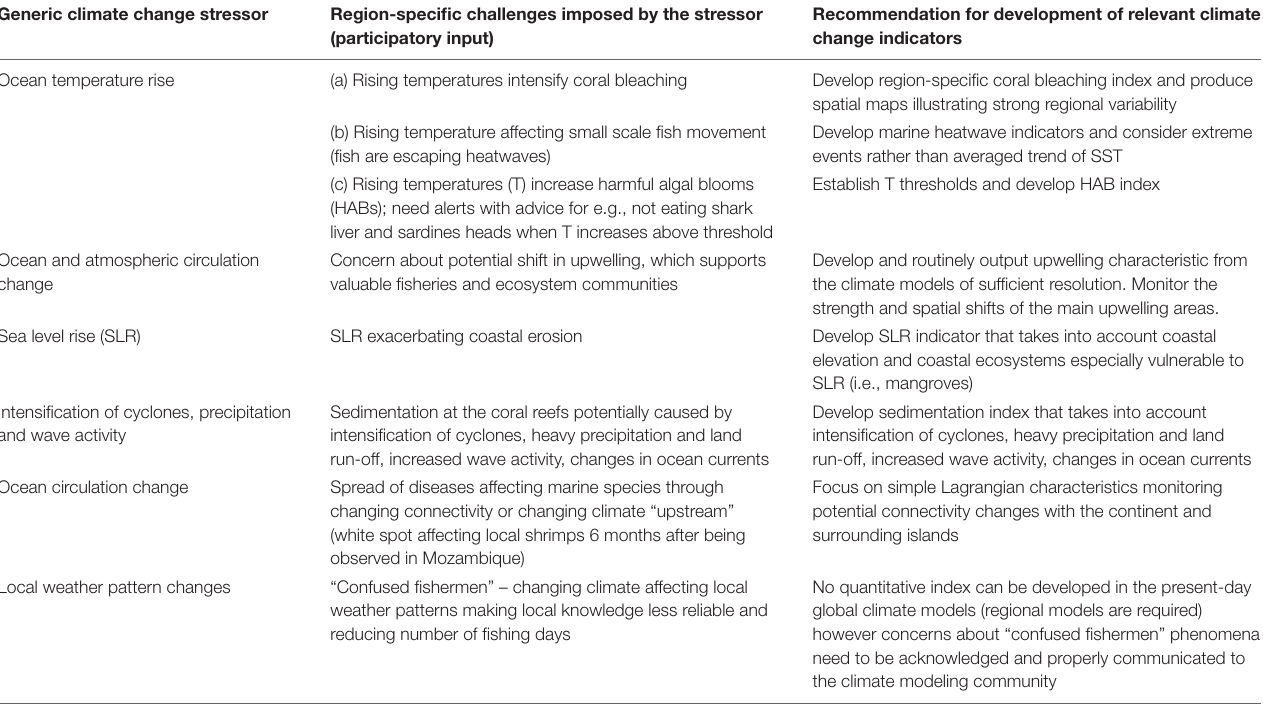
TABLE 1 | Challenges resulting from climate change stressors identified by participants in